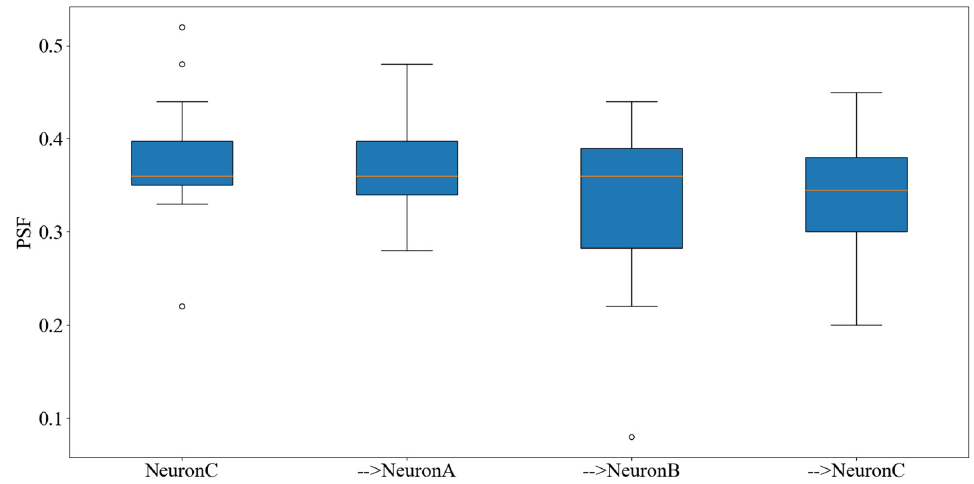
Figure 9. PSF distribution diagram of three neurons model 1(b-3) in different connection States.